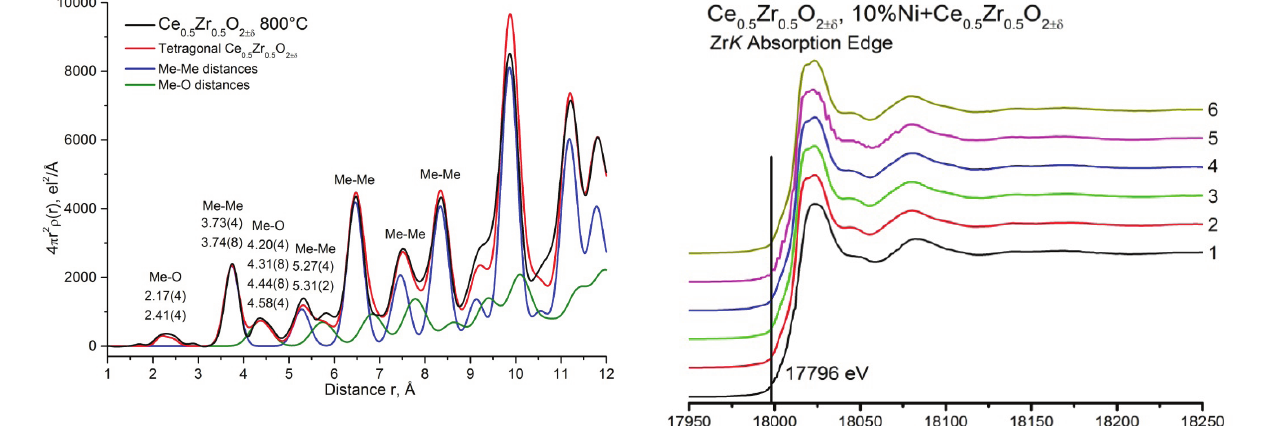
Zr O 800°С and model 0.5 0.5 2±δ